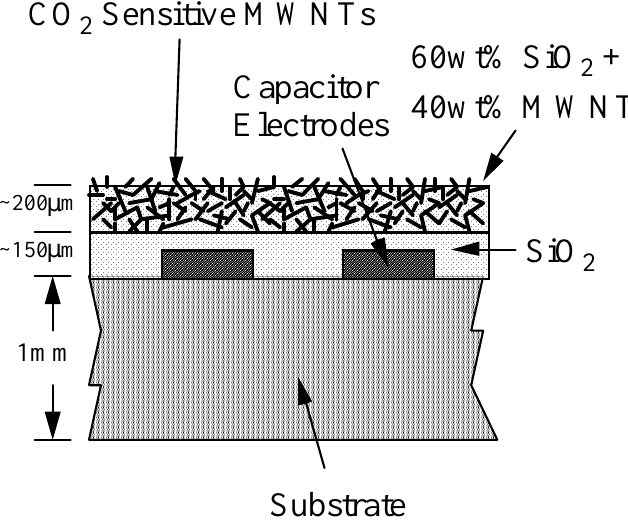
Figure 5. Cross sectional view of the interdigital capacitor. An electrically insulating 150 µ m- thick SiO layer is first applied to protect the sensor, followed by a 200 µm MWNT-SiO 2 sensing